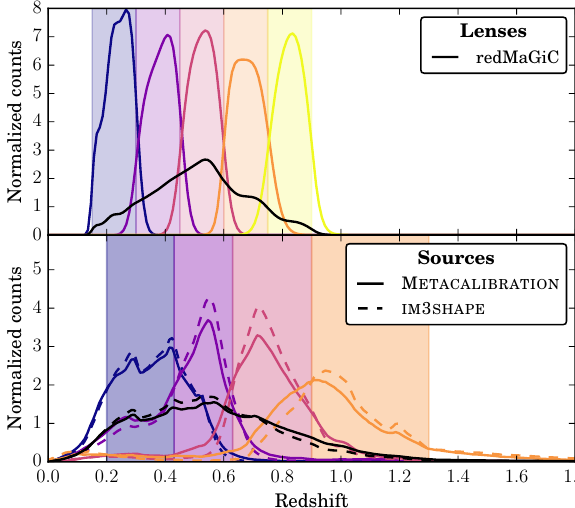
Figure 3. Photometric redshift distributions for the galaxy position (lens) and shear (sources) catalogs. The shaded regions mark the redshift bins: galaxies are divided according to their mean photo-z estimate. The redshift distributions of galaxies in each bin is shown with colored lines, while their overall redshift distributions with black lines. While the lens galaxies are analyzed using only one pipeline (redMaGiC), source galaxies are analyzed with two pipelines (IM3SHAPE and METACALIBRATION). From Abbott et al.